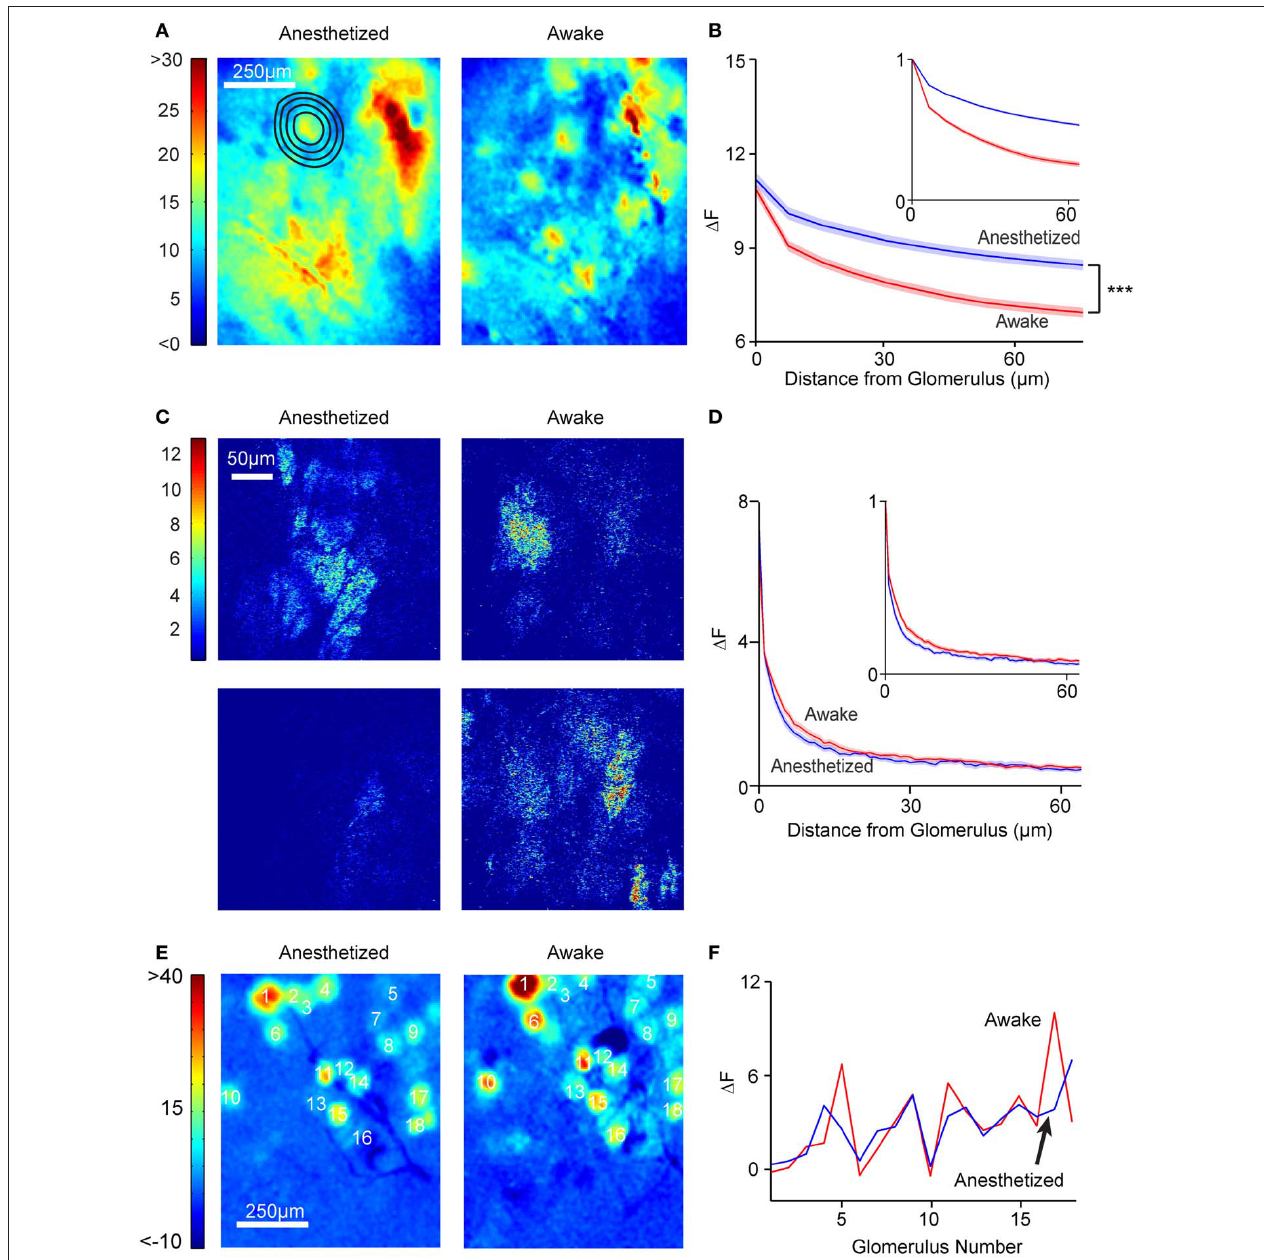
FIGURE 6 | Anesthetized, but not awake animals, have diffuse activation patterns. (A) Widefield glomerular activation pattern in an anesthetized (left) and awake (right) mouse after presentation of 10% ethyl tiglate. Note that it is easier to distinguish individual activated glomeruli in the awake mouse. (B) (cid:2) F as a function of distance from the glomerulus in anesthetized ( n = 6 mice, 256 glomeruli) and awake ( n = 6 mice, 196 glomeruli) mice. Inset, (cid:2) F values are normalized to the (cid:2) F of the glomerulus. Shaded areas denote standard error. (C) Response images ( (cid:2) F) obtained with multi-photon